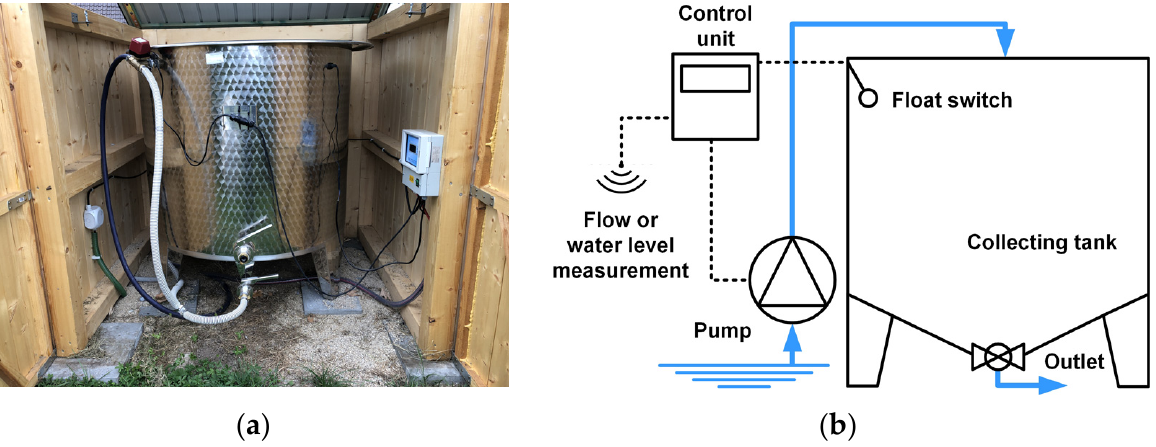
Figure 2. Schematic of the large-volume sampler: ( a ) photo of the large-volume sampler; ( b ) sketch of the large-volume sampler [38].